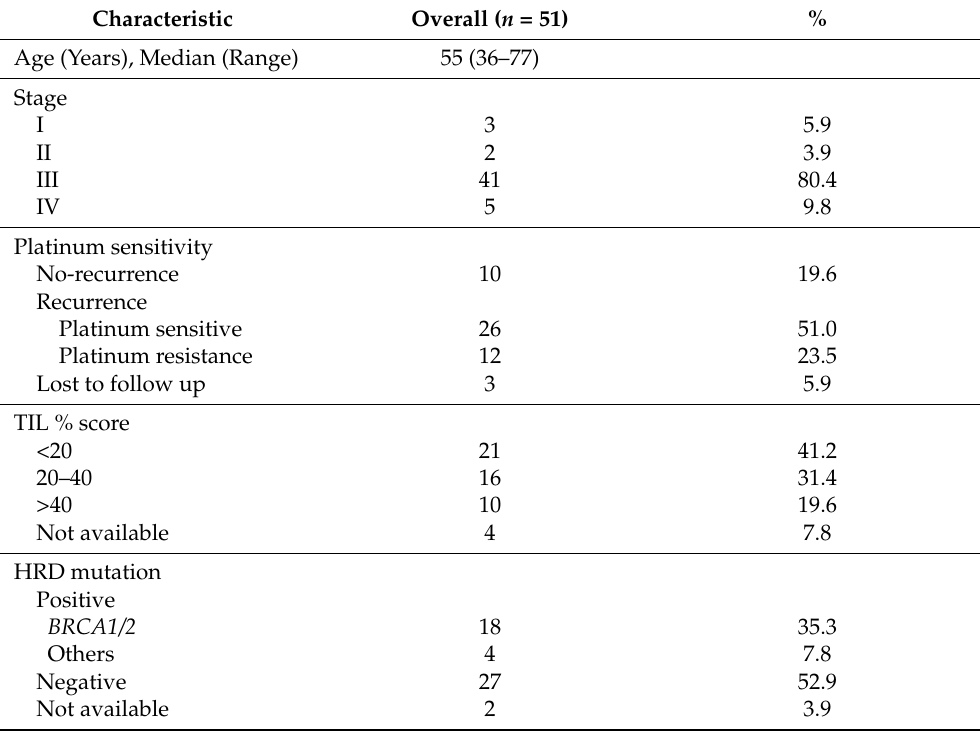
Table 1. Clinical Characteristics of Patients with